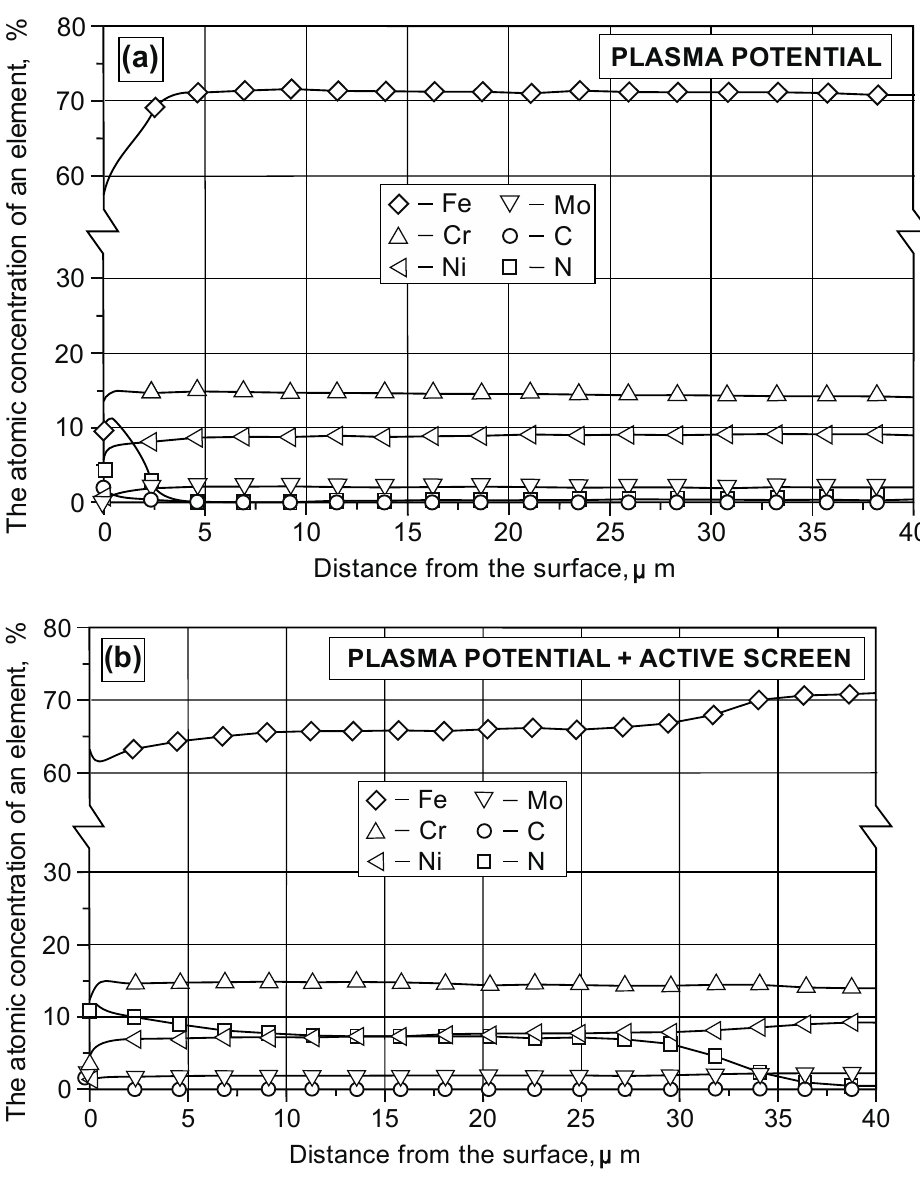
Figure 2. Distribution of the element concentration in the surface layer on the austenitic 316L steel substrate depending on the location in the glow chamber. Temperature T = 460 °C, time t = 11 h: ( a ) substrate depending on the location in the glow chamber. Temperature T = 460 ◦ C, time t = 11 h: plasma potential, ( b ) plasma potential + active screen. ( a ) plasma potential, ( b ) plasma potential + active